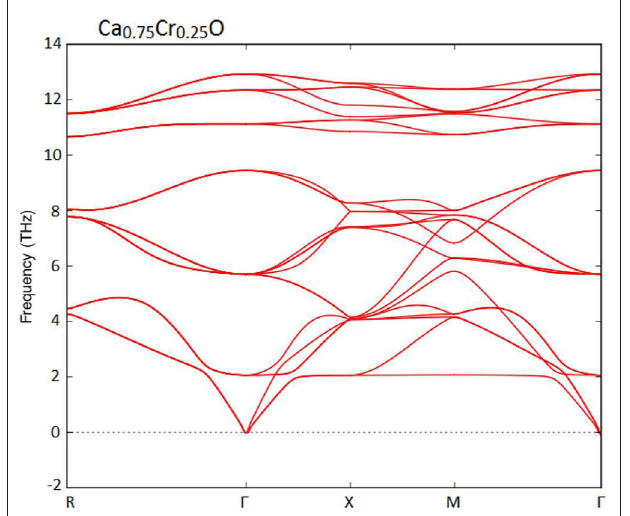
FIGURE 2 | Phonon spectra for Ca 0.5 Cr 0.5 O.